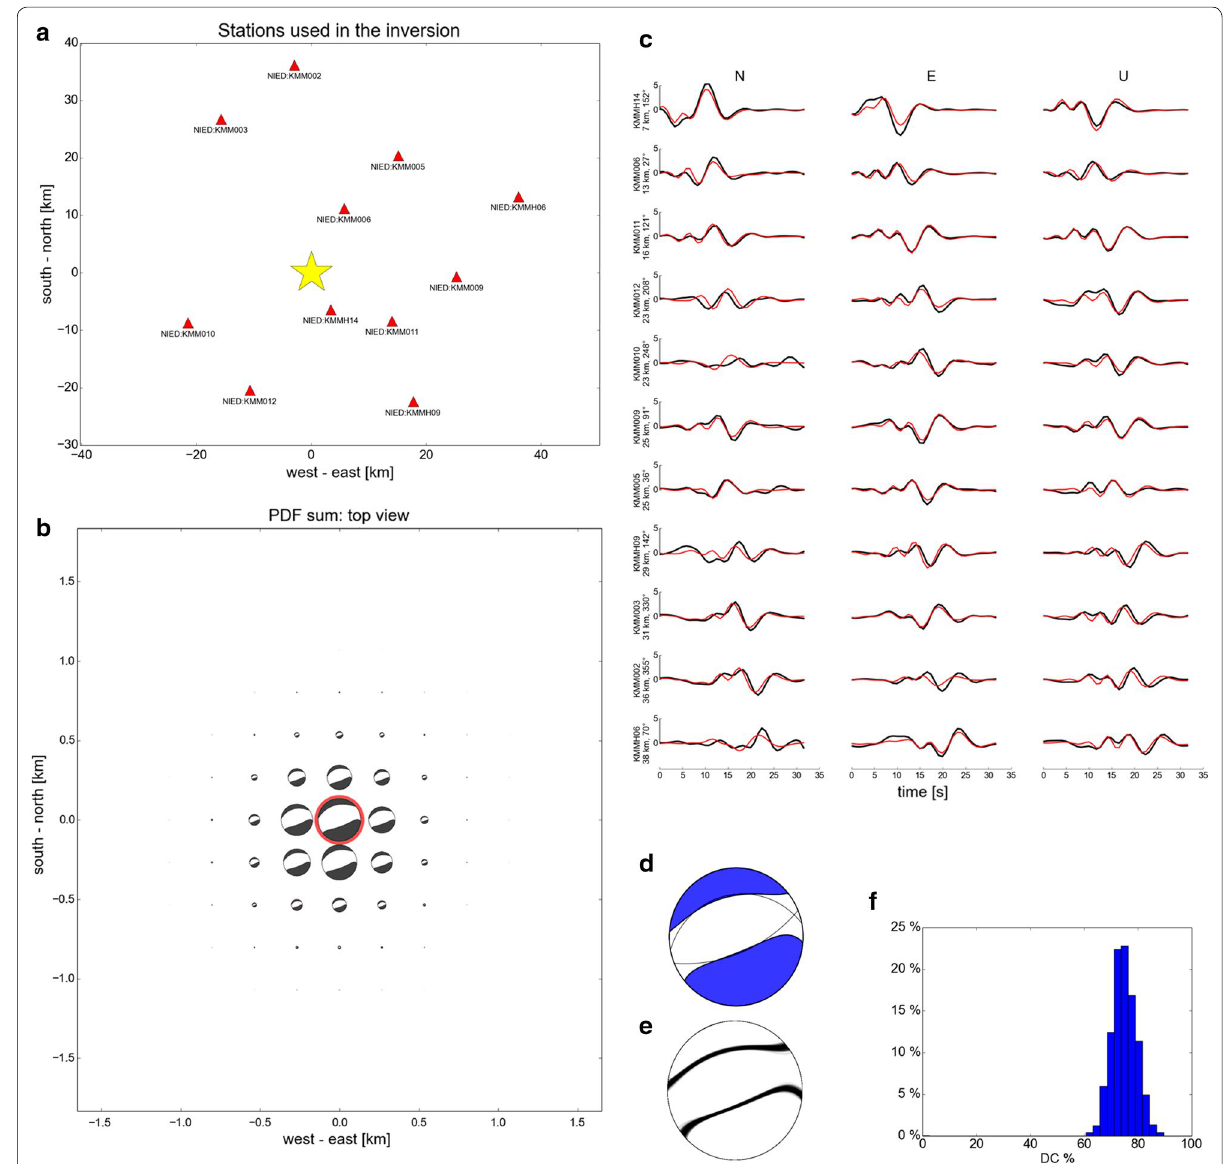
Fig. 5 Same as Fig. 3, but for the M JMA 5.4 aftershock from 2016/4/16 16:02:01 JST (event No. 7); a the map of strong motion stations (red triangles) used for the CMT inference; b marginal PDF of the CMT location in a horizontal slice indicated by the size of the beach-balls; the beach-balls depict inferred MTs at the individual spatial points. The beach-ball highlighted by red circle is the solution with the highest variance reduction (the best fitting solution); c the comparison between measured and synthetic standardized waveforms for the best fitting solution; d the beach-ball repre- sentation of the best fitting CMT; e the uncertainty of the mechanism depicted by 1000 random possible solutions drawn from the ten-dimensional posterior PDF; f histogram of the DC